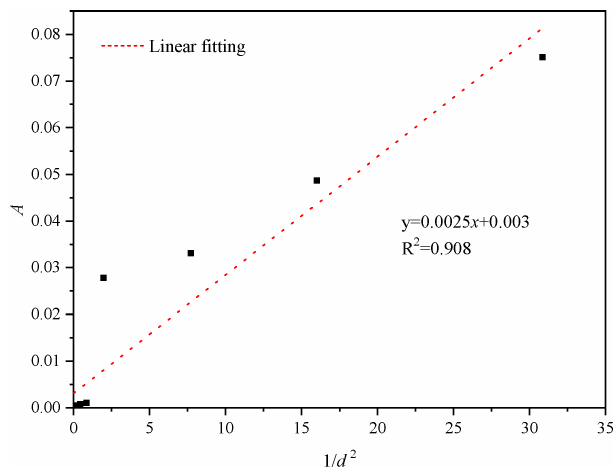
Figure 13. Variation of A with 1 /d 2 for different homogeneous par- ticle sizes.